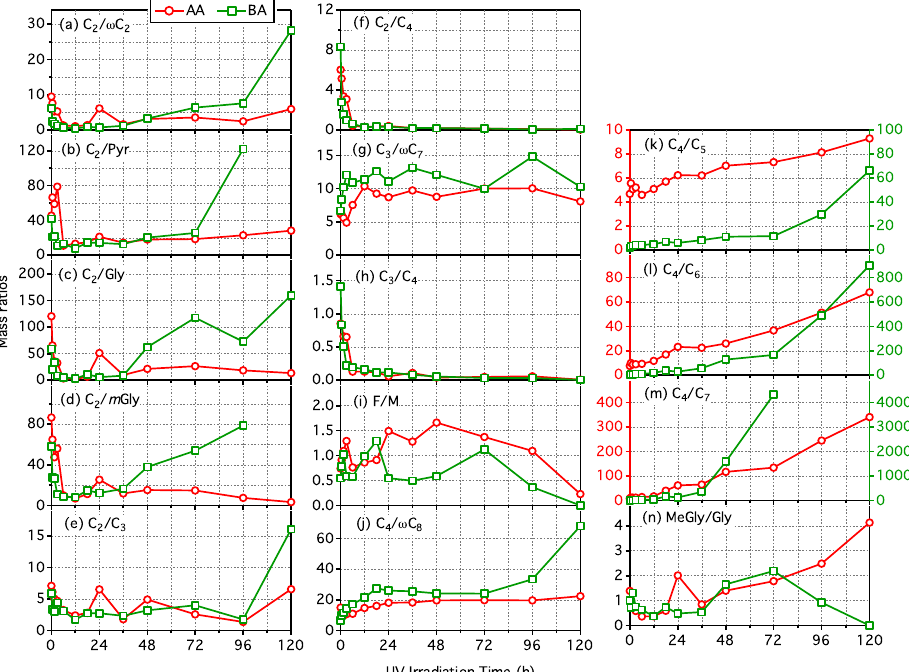
Figure 6. Changes in mass ratios of selected diacids, oxoacids and α -dicarbonyls as a function of UV irradiation time in AA and BA.